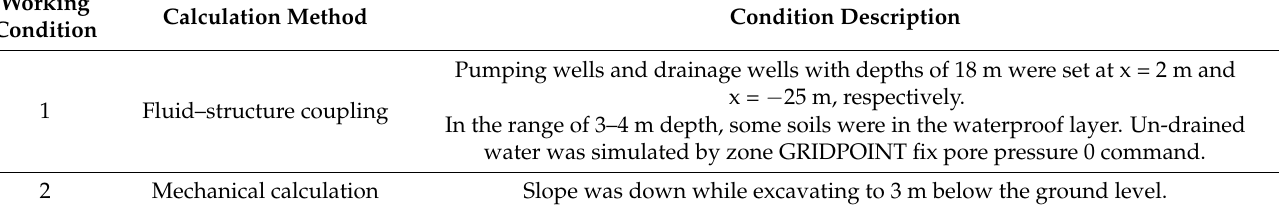
Figure 17. The boundary conditions for flow and displacements.